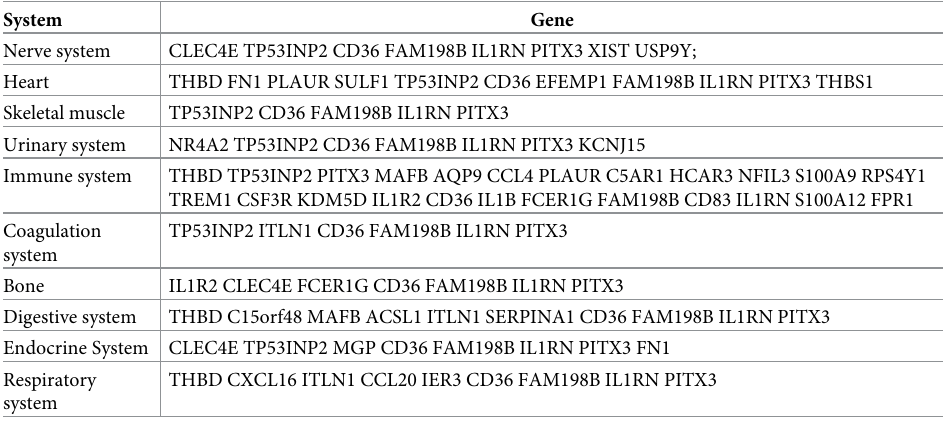
Table 2. Summary of gene